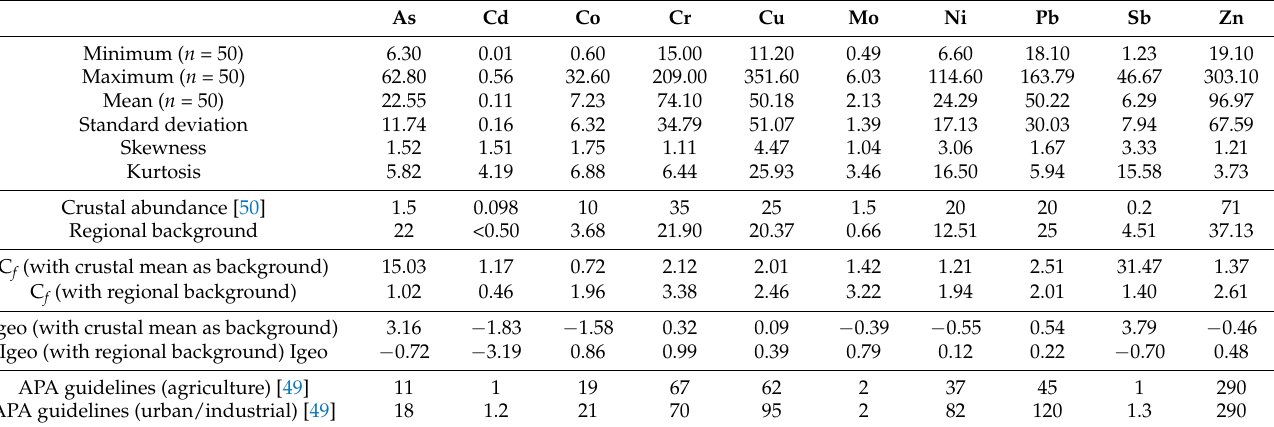
Table 2. Descriptive statistics for PTE concentrations in the studied soils (in mg kg − 1 ) and determined pollution